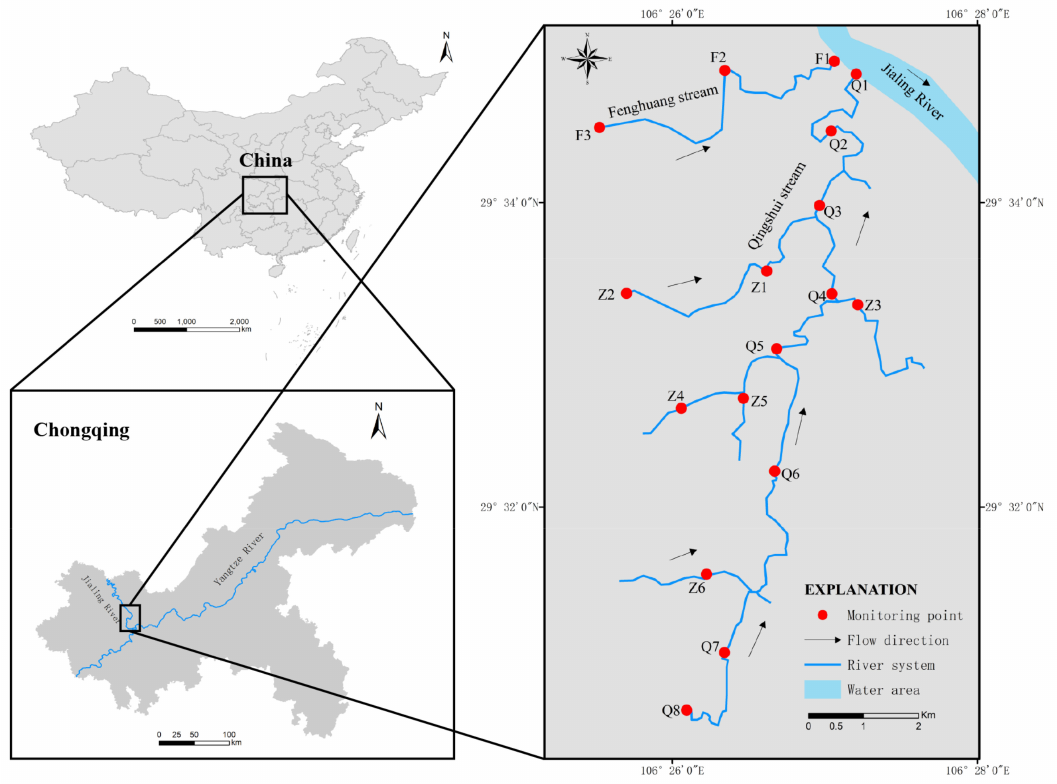
Figure 1. Distribution of monitoring